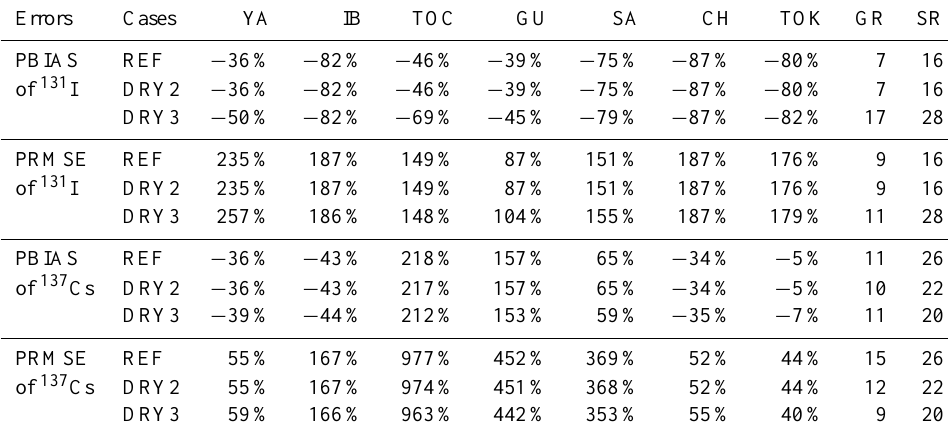
Table 6. The PBIAS and PRMSE of total daily depositions of 131 I and 137 Cs with different dry deposition schemes. GR represents the global ranks for PBIAS or PRMSE, and SR represents for the sum of the global ranks. The definition of GR and SR is shown in Sect. 3.1.2. “YA”, “IB”, “TOC”, “GU”, “SA”, “CH” and “TOK” represent the stations “YAMAGATA”, “IBARAKI”, “TOCHIGI”, “GUNMA”, “SAITAMA”, “CHIBA” and “TOKYO”,